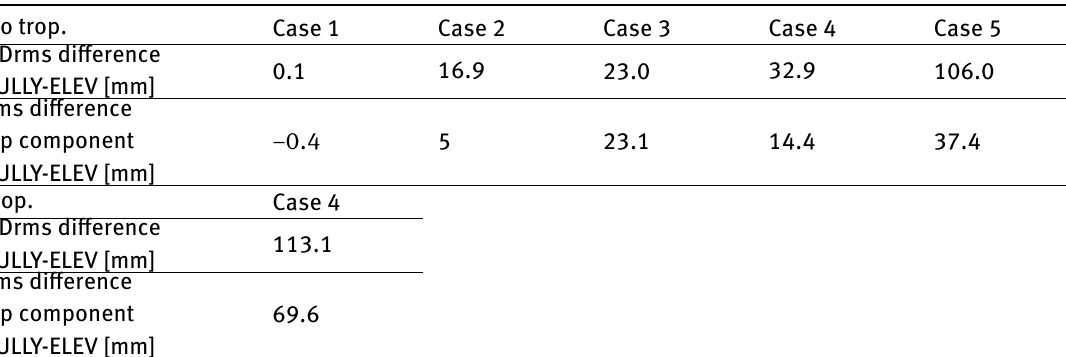
Table 1: 3Drms differences (FULLY-ELEV) model and rms differences for the Up component. Five different batch lengths are computed. The ambiguities are let